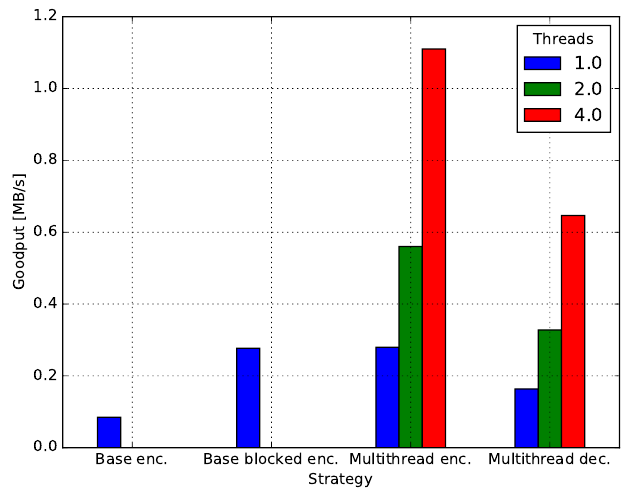
Figure 13. Encoding and decoding performance for g = 1024. Block size: 128 × 128.